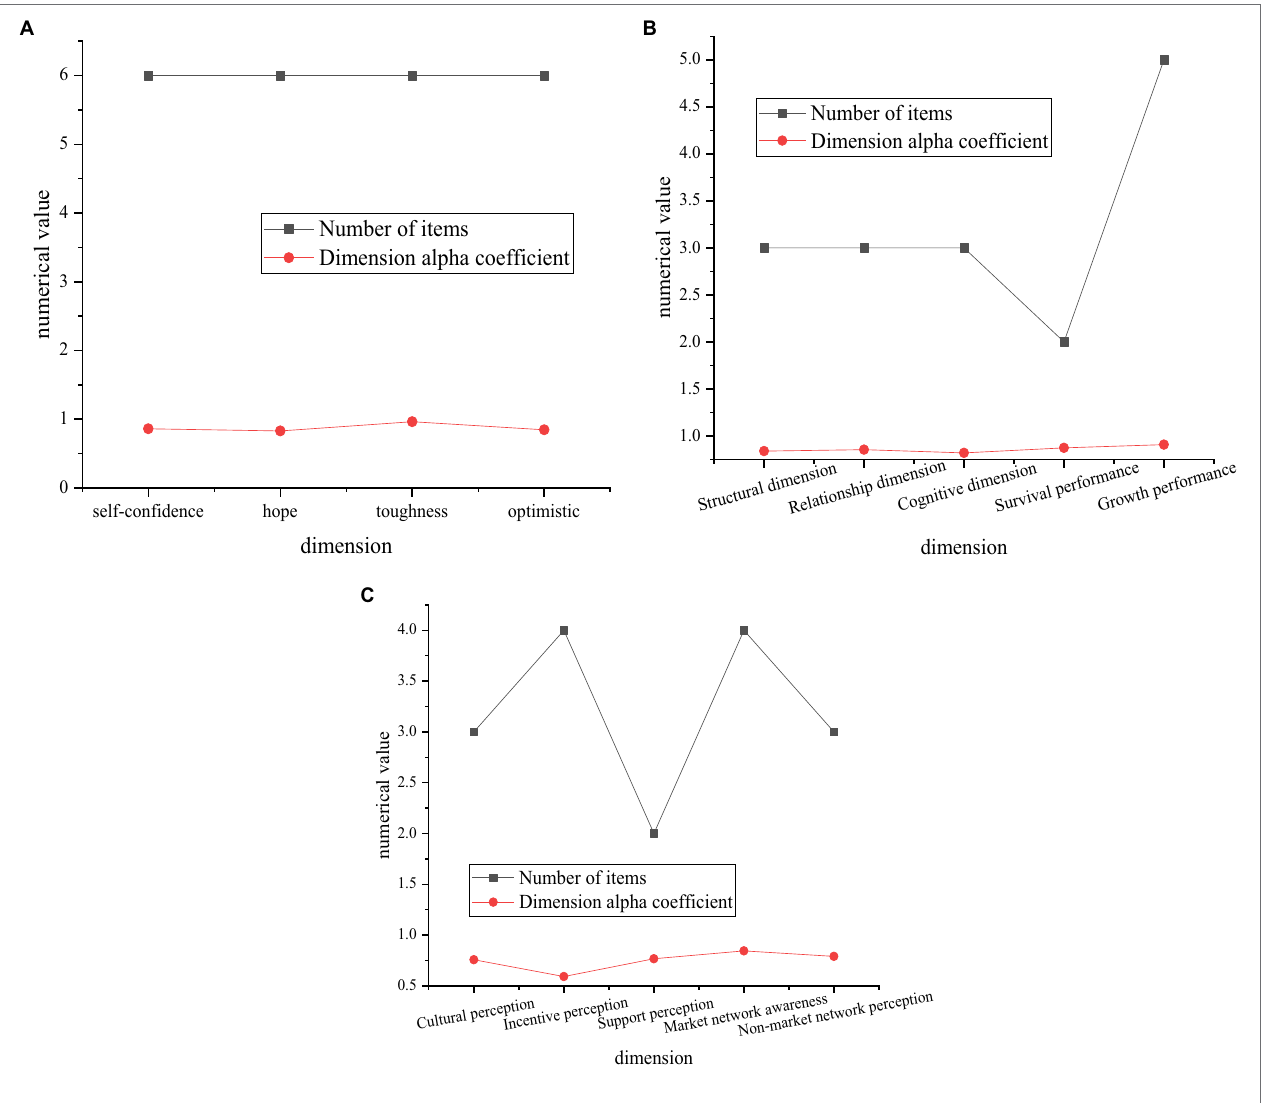
FIGURE 7 | Reliability analysis results of the scale (A) shows the reliability analysis results of psychological capital scale, (B) shows the reliability analysis results of social capital and entrepreneurial performance scale, and (C) shows the reliability analysis results of entrepreneurial environment perception